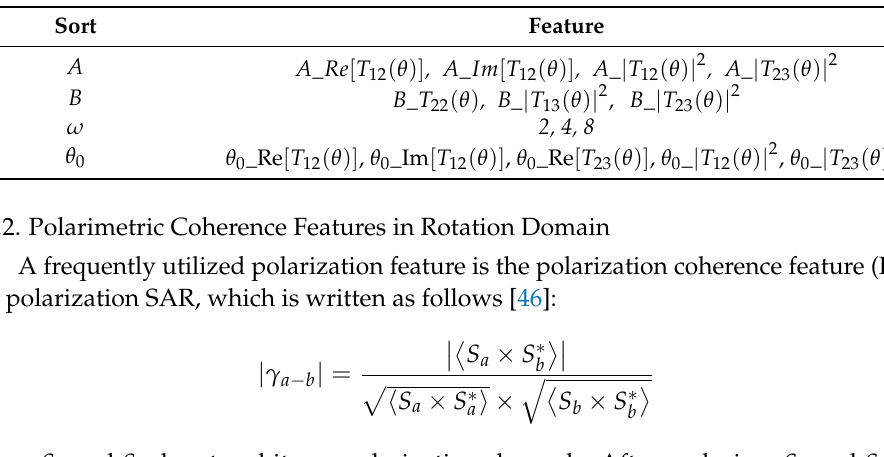
Table 3. Features related with oscillation